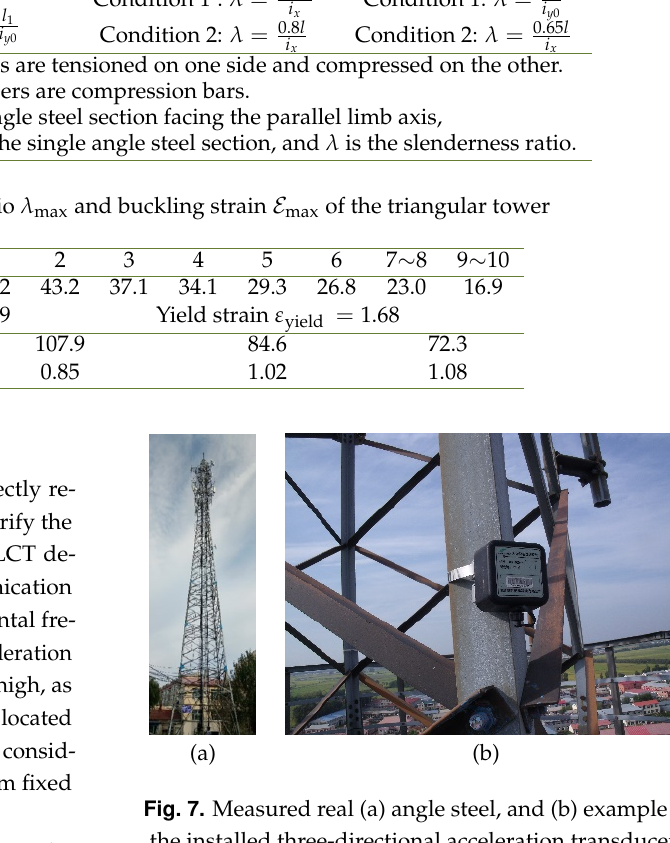
sistent with the bedrock motion characteristics. When